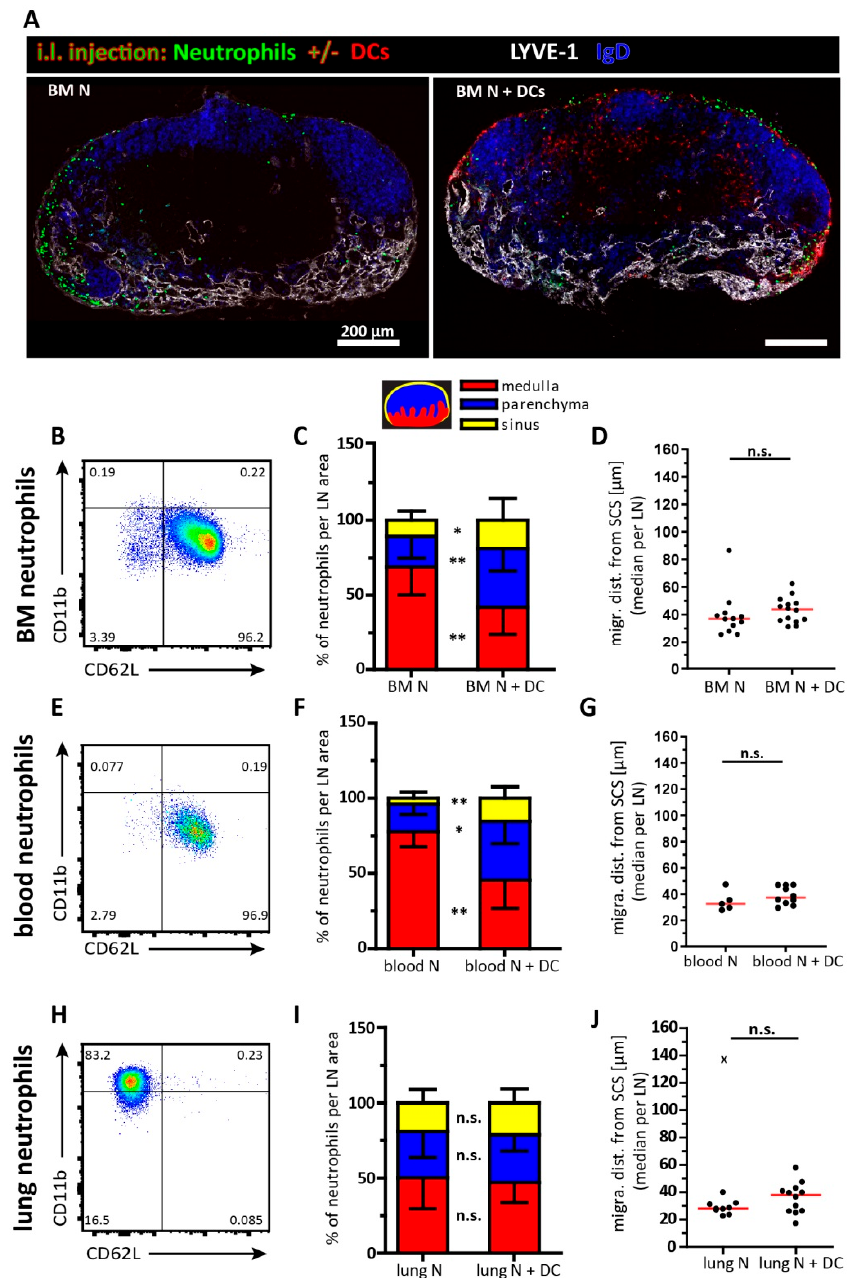
Figure 4. Positioning and migration of bone marrow, blood and lung neutrophils in co-injections with DCs. ( A ) Cryosections of popliteal lymph nodes 4 h after i.l. injection of bone marrow neutrophils (green) alone (left picture) or together with DCs (red; right picture). Lymph node sections were stained with the following antibodies: anti-LYVE-1 (white) and anti-IgD (blue). Scale bar 200 µm. Representative data of 10–12 lymph nodes per group are shown. ( B ) FACS plot showing the activation status of bone marrow neutrophils (CD11b + Ly6G + ). Representative data of more than 3 independent experiments are shown. ( C ) Distribution of bone marrow neutrophils in lymph node areas: mean and SD of medulla (** p = 0.0016), parenchyma (** p = 0.0022) and sinus (* p = 0.0373). A total of 4 sections per lymph node were analyzed using the Mann–Whitney test. ( D ) Median migration distance of bone marrow neutrophils from the subcapsular sinus per lymph node. Dots, lymph nodes; red line, median; Mann–Whitney test; p = 0.1729. Data were pooled from 10–12 different lymph nodes. ( E ) FACS plot displaying the activation status of blood neutrophils (CD11b + Ly6G + ) derived from an MVA–infected mouse (intranasal infection one day before cell isolation). Representative data of 3 independent experiments are shown. ( F ) Distribution of blood neutrophils in lymph node areas: mean and SD of medulla (** p = 0.008), parenchyma (* p = 0.0193) and sinus (**